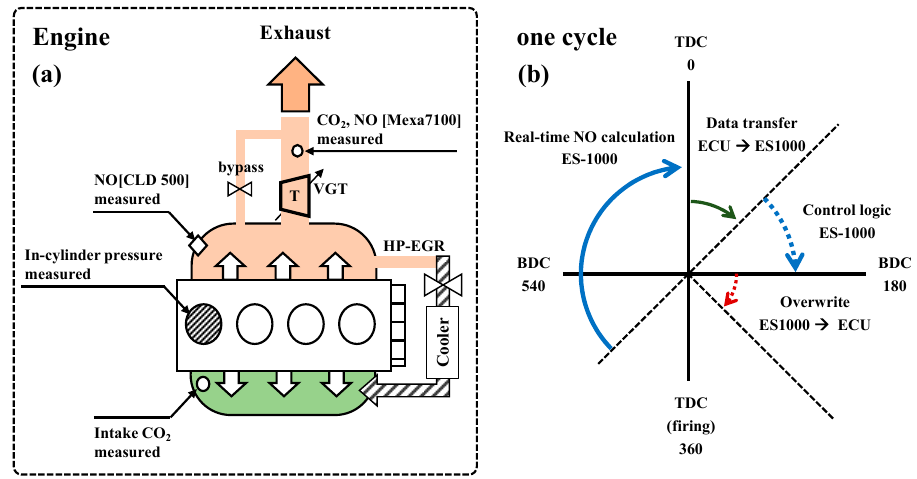
Figure 1. ( a ) Schematic overview of the experimental setup; ( b ) NO calculation procedure in a cycle (solid arrows) with the control process (dotted arrows).